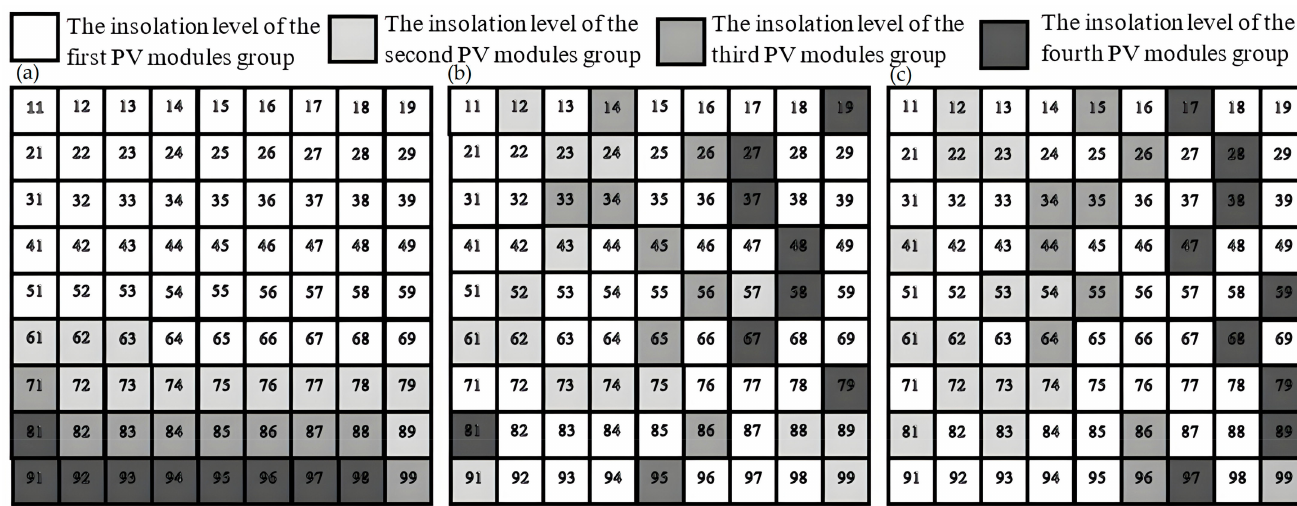
Figure 8. The configuration scheme created by ( a ) the TCT rPV, ( b ) the rPV system based on the MFNN, and ( c ) the rPV system based on